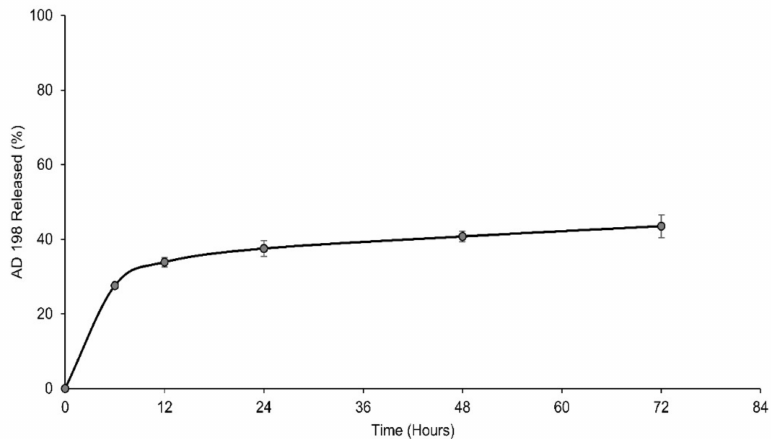
Figure 4. AD 198 release profile from LCLA at 37 ◦